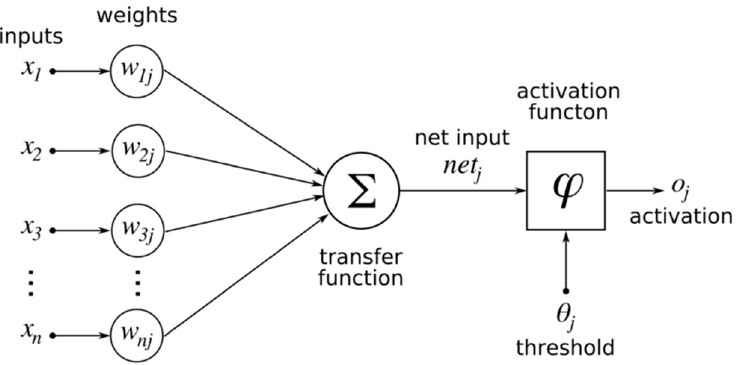
Figure 3. Perceptron architecture in its simplest form, showing the three main layers of an ANN. Each activation function has a different equation. The general formula is shown in Equation (1), where x is the input, w is the weight, b is the bias weight value, and n is the number of input nodes starting from j = 1.